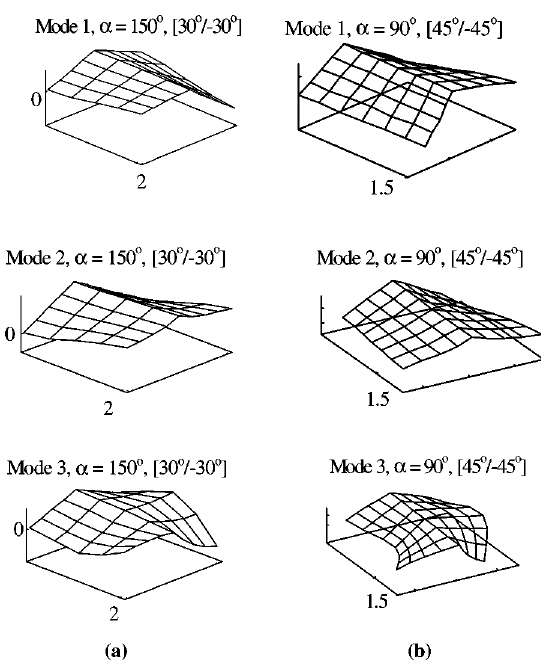
Fig. 4. First, second and third mode shapes of E-glass–Epoxy cantilever composite single fold folded plate with (a) crank an- gle (cid:11) = 150 (cid:14) , ply arrangement 30 (cid:14) = (cid:0) 30 (cid:14) , and (b) crank angle (cid:11) = 90 (cid:14) , ply arrangement 45 (cid:14) = (cid:0) 45 (cid:14) . increasing trend with the increase in the number of lay- ers, while the fibre angles and thickness are kept in- variant. Anti-symmetric plies have shown higher fun- damental